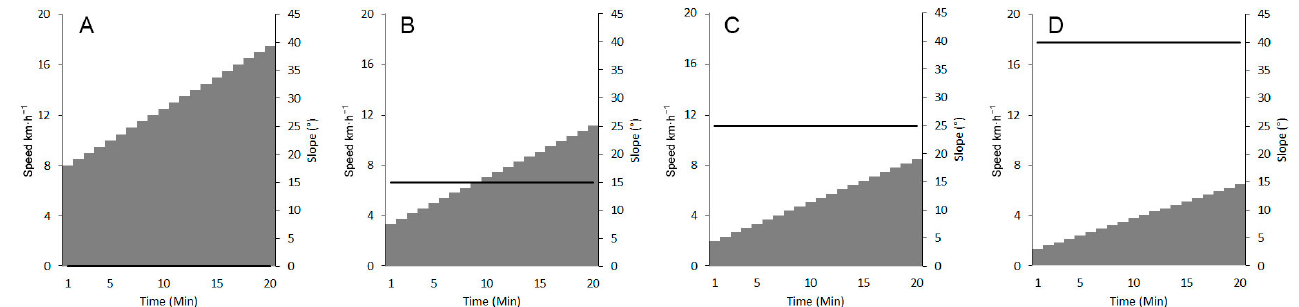
Figure 1. Graphical representation of each protocol performed by participants. The grey area repre- sents the speed in km·h, while the black solid line represents the slope gradient in degrees. Protocol represents the speed in km · h, while the black solid line represents the slope gradient in degrees. designs are displayed from 0° to 40° from left to right. (( A ): 0°, ( B ): 15°, ( C ): 25° and ( D ): 40°). Protocol designs are displayed from 0 ◦ to 40 ◦ from left to right. (( A ): 0 ◦ , ( B ): 15 ◦ , ( C ): 25 ◦ and ( D ): 40 ◦